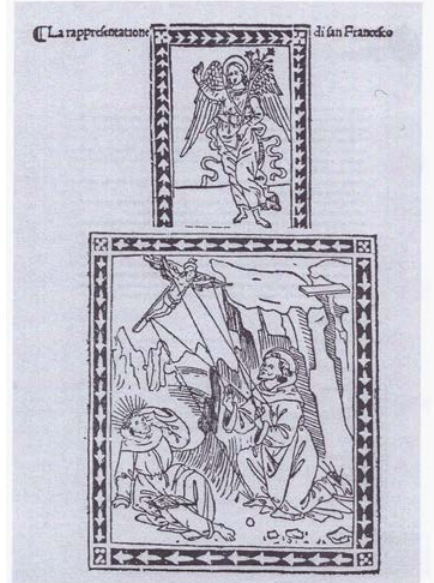
Figure 14 – Antonia Pulci, La rappresentazione di San Francesco , s.n.t. [but Firenze, Bartolomeo de’ Libri, around 1495], f. a1r (BNCF, Banco Rari 189.m). By permission of Ministero per i beni e le attività culturali / Biblioteca Nazionale Centrale. Firenze